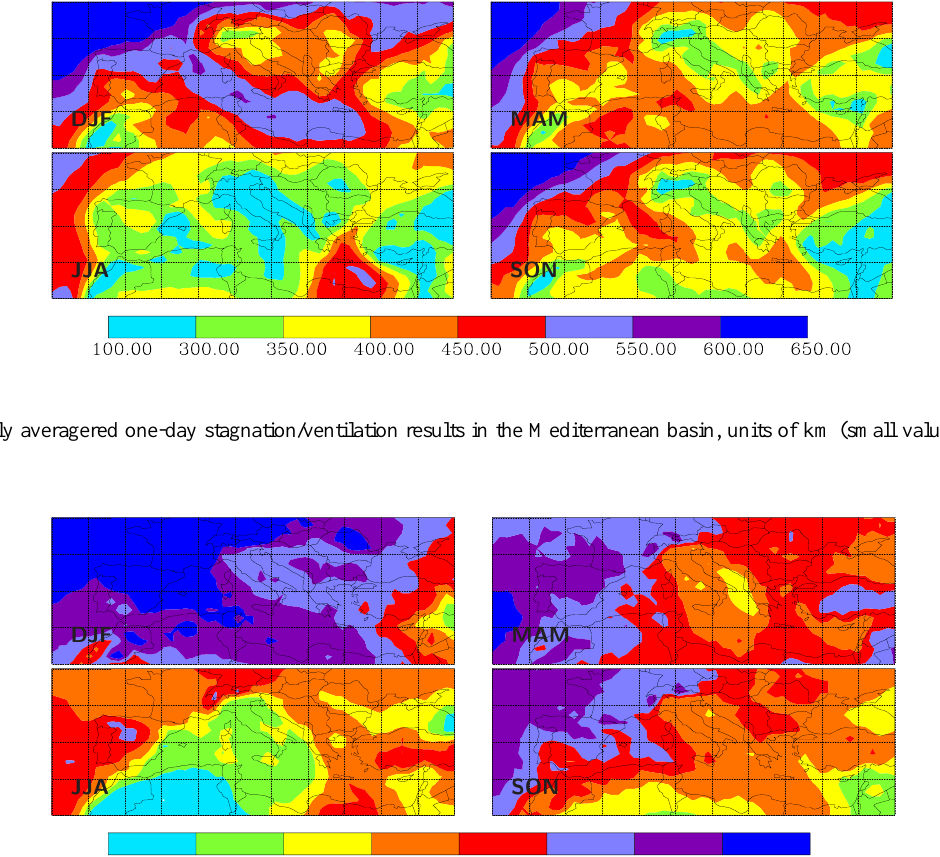
Fig. 6. As Fig. 5 but for five day